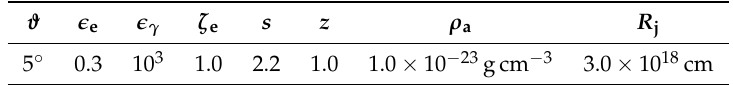
Table 2. Emission parameters used for the calculation of the non-thermal radiation.